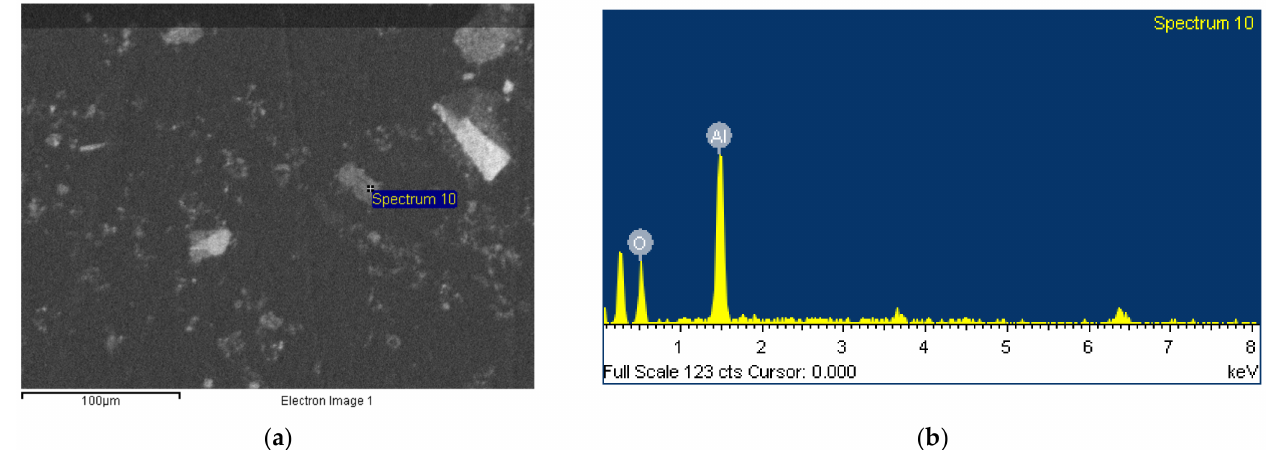
Figure 7. SEM of AoG sample—( a ) image of aluminium oxide phase. ( b ) EDS of aluminium oxide phase.